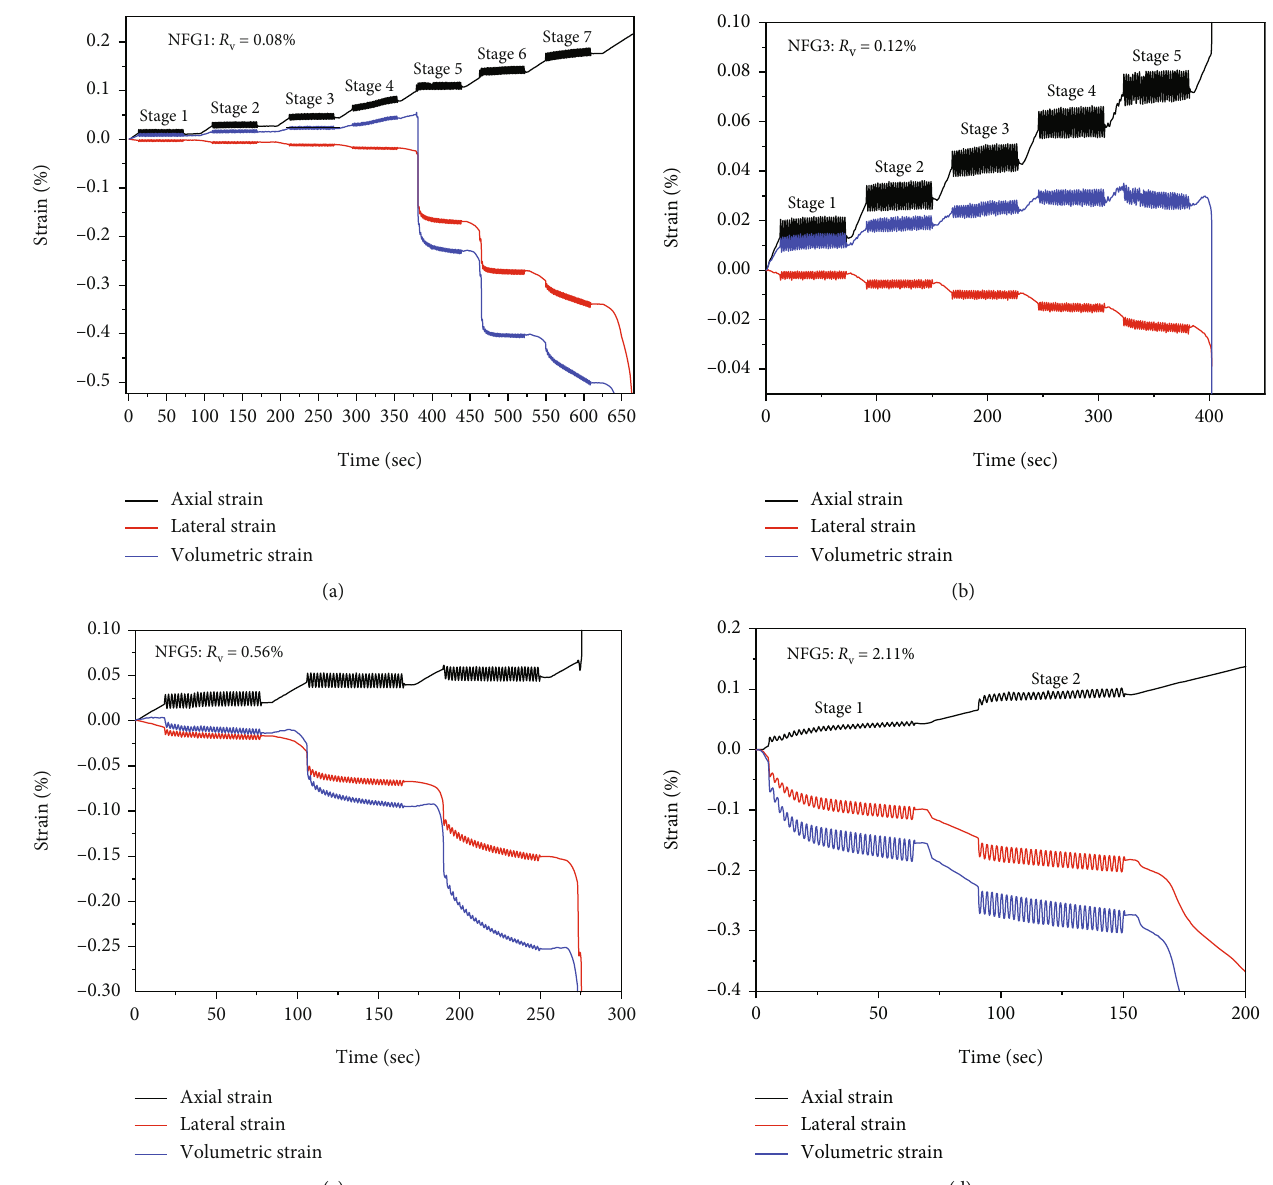
Figure 4: Fatigue deformation characteristics of the tested granite samples containing di ff erent natural fracture volumes. (a – d) The natural fracture volume ratio is 0.08%, 0.12%, 0.56%, and 2.11%,